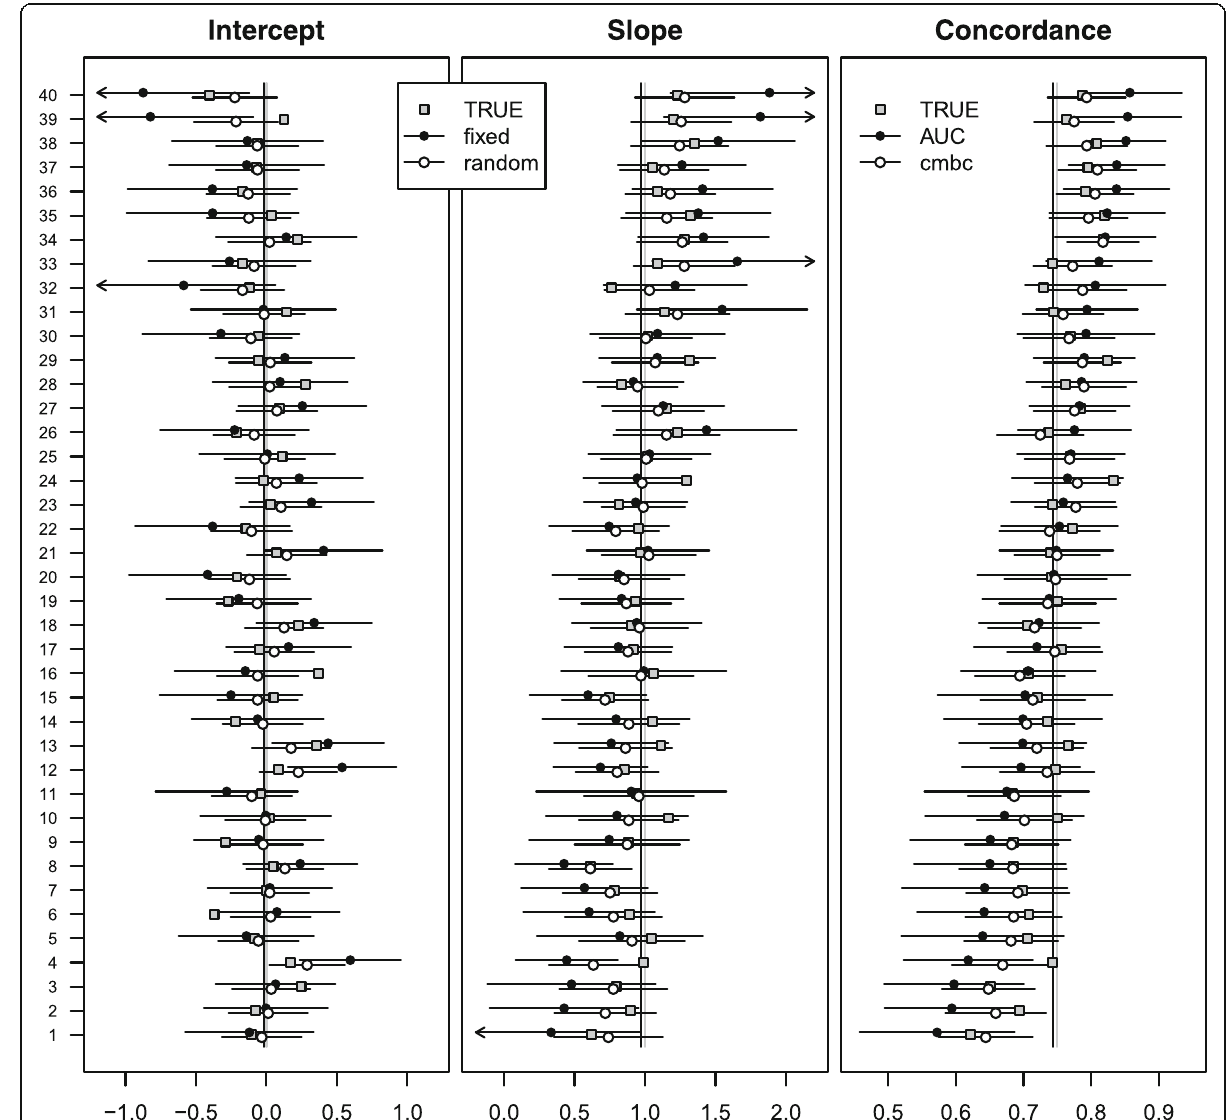
Fig. 5 Performance measures across 40 centers of 200 simulated patients with varying case-mix heterogeneity. Gray squares represent true values of intercept, slope, and concordance probability. Closed dots represent fixed effect intercept estimates; fixed effect slope estimates; and c-indexes in the first, second, and third panel, respectively. Open dots represent random effects intercept estimates; random effects slope estimates; and calibrated model-based concordance estimates in the first, second, and third panel, respectively. Gray vertical lines represent effect estimates of intercept and slope in the original regression model, together with the expected pooled concordance. Black vertical lines represent fixed effect estimates of intercept and slope in a multilevel regression model, together with the expected pooled